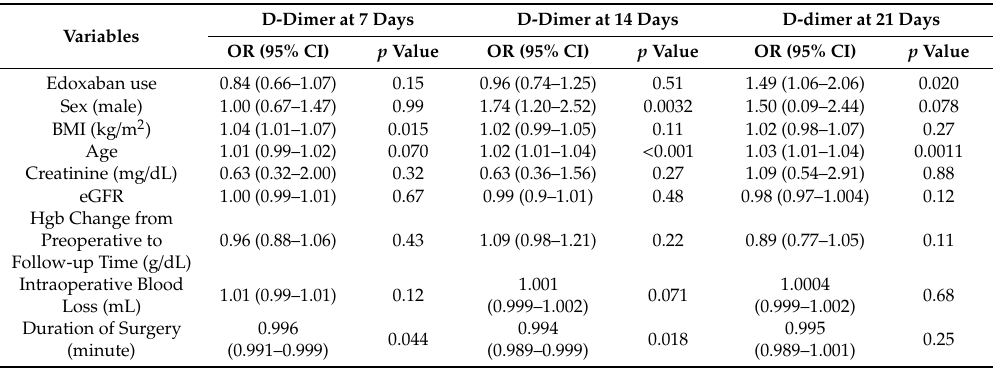
Table 2. Correlation coe ffi cients and p values for each variable obtained by multivariate regression analysis with D-dimer levels as the dependent variable.